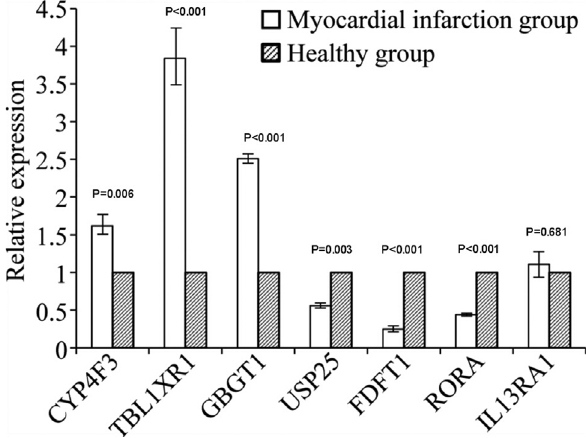
Figure 2 - Verification result: Relative expression of the candidate genes analyzed by